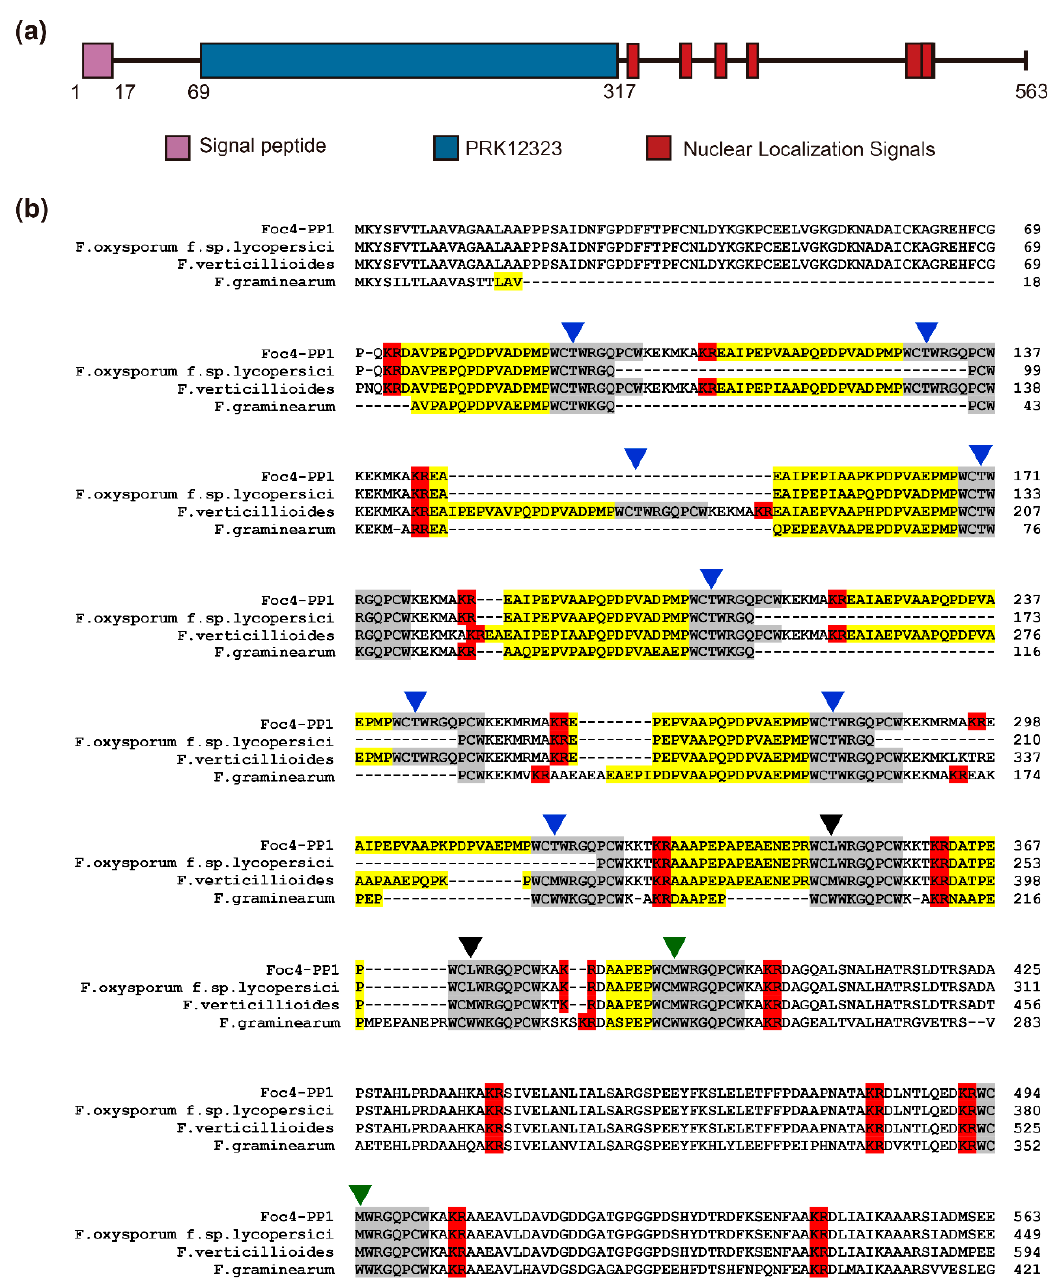
Figure 1. Sequence analysis of the Foc4-PP1. ( a ) The domain prediction of Foc4-PP1. The six putative nuclear localization signals are 325 PCWKKTK 331 , 355 PCWKKTK 361 , 376 PCWKAKR 382 , 396 PCWKAKR 402 , 500 PCWKAKR 506 , and 491 KRWCMWRGQPCWKAKRA 507 , respectively. ( b ) Multiple sequence alignment of the deduced Foc4-PP1 amino acid sequences with predicted α -pheromone precursors from F. oxysporum f. sp. Lycopersici (FOXG_08636), F. graminearum (FGSG_05061), and F. verticillioides (FVEG_06038). Predicted KR and RR cleavage signals for KEX2-like endopeptidases are highlighted in red. Predicted maturation signals characterized by the presence of XA or XP dipeptide repeats are highlighted in yellow. Predicted mature α -pheromone decapeptide repeats are highlighted in grey. Colored arrowheads indicate differences between the decapeptide repeats at the third amino acid.